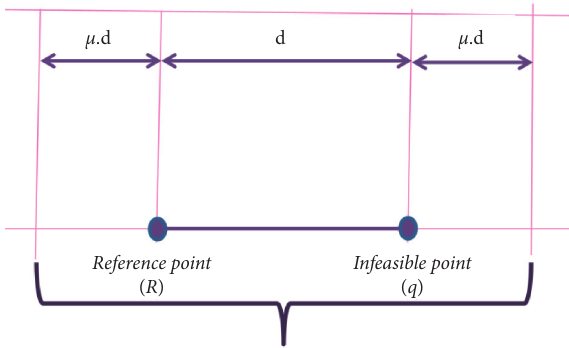
Figure 4: Constraint-handling